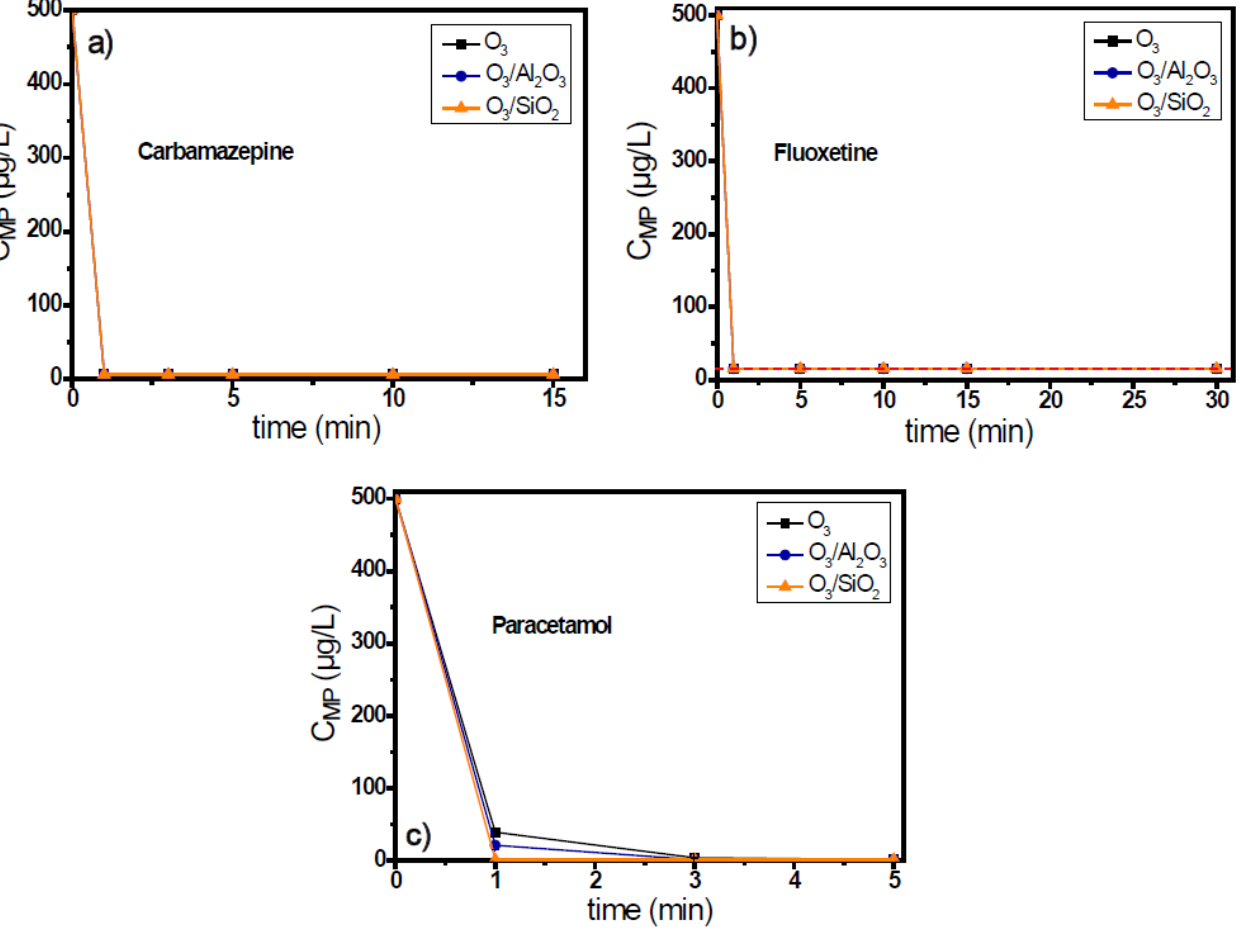
Figure 4. Degradation of micropollutants presenting high ozone reactivity, ( a ) carbamazepine, ( b ) fluoxetine, and ( c ) paracetamol, during the application of catalytic ozonation with the use of Al 2 O 3 and SiO 2 as potential catalysts compared to single ozonation in natural potable water matrix. Experimental conditions: C MPs 500 μg/L, C catalyst 0.5 g/L, C O3 2 mg/L, pH 7.8, Temperature 23 ± 2 °C.